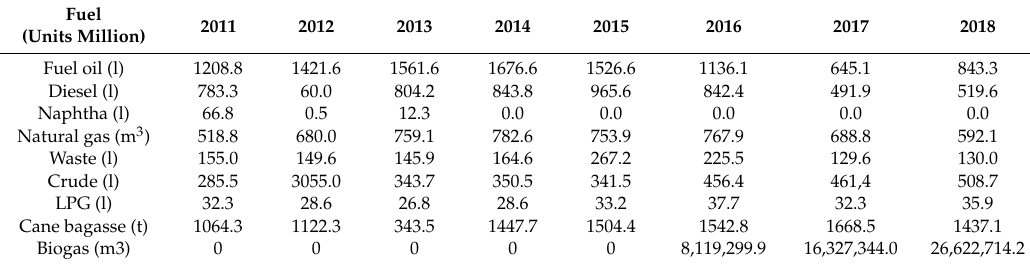
Figure 16. Evolution of CO 2 emission margins and Gross Electricity Production. Table 4. Consumption of fuel used in electricity